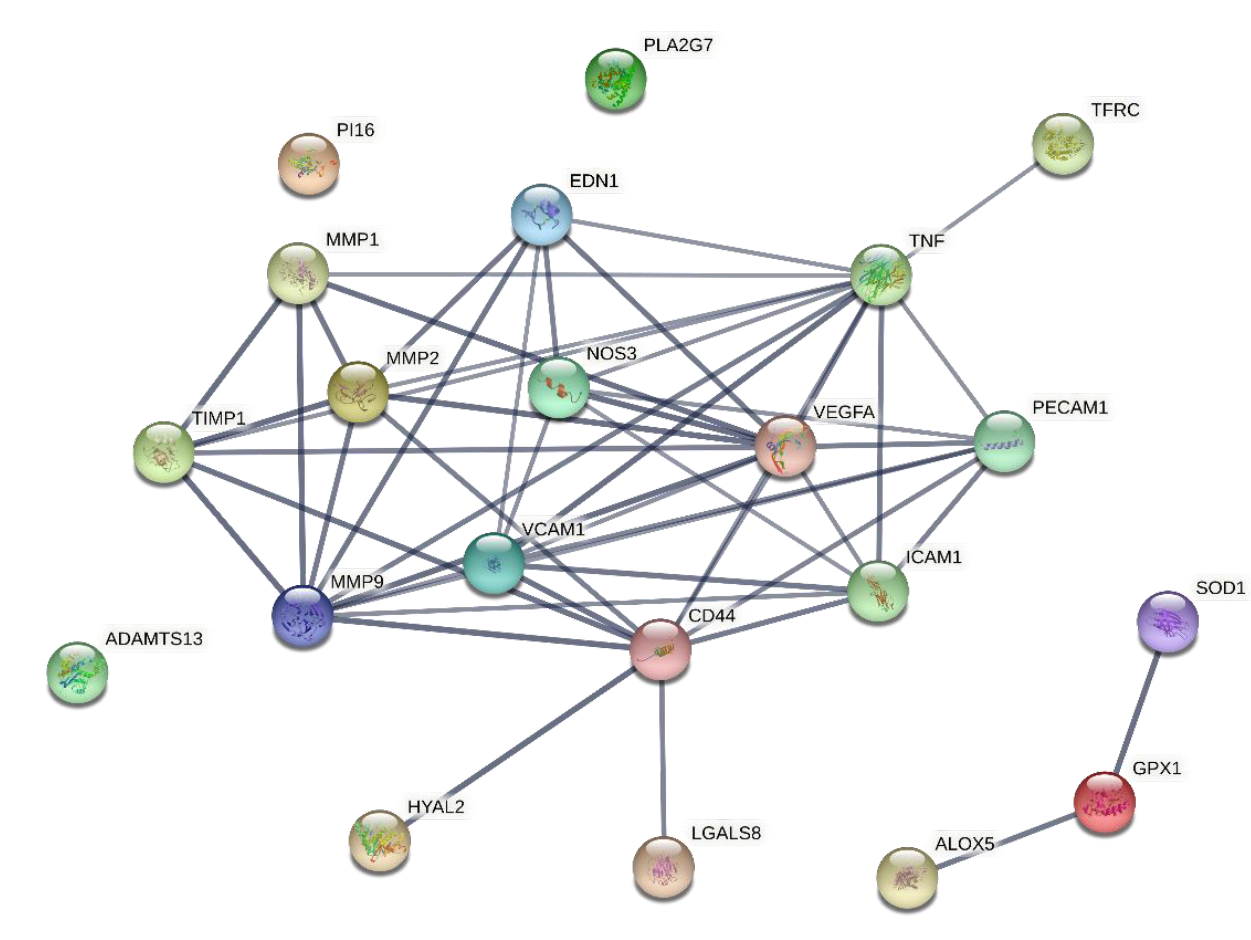
Figure 2. Protein–protein association network visualized by STRING. Each node represents all the proteins produced by a single, protein-coding gene locus, while each edge represents the number of protein–protein associations. Only interactions with a high confidence score of ≥ 0.7 are shown. The color saturation of the edges represents the confidence score of the functional association [17]. ADAMTS13 = ADAM Metallopeptidase with Thrombospondin Type 1 Motif 13; ALOX5 = Arachi- donate 5-Lipoxygenase; CD31 = Platelet And Endothelial Cell Adhesion Molecule 1; CD44 = Hyalu- ronan receptor; EDN1 = Endothelin 1; GPX1 = Glutathione peroxidase 1; HYAL2 = Hyaluronidase 2; ICAM1 = Intercellular Adhesion Molecule 1; LGALS8 = Galectin 8; MMP1 = Matrix metallopro- teinase 1; MMP2 = Matrix metalloproteinase 2; MMP9 = Matrix metalloproteinase 9; NOS3 = Endo- thelial nitric oxide synthase; PI16 = Peptidase Inhibitor 16; PLA2G7 = Phospholipase A2 Group VII; SOD1 = Superoxide dismutase 1; TFRC = Transferrin Receptor; TIMP1 = TIMP Metallopeptidase Inhibitor 1; TNF = Tumor Necrosis Factor; VCAM1 = Vascular cell adhesion molecule 1; VEGFA = Vascular endothelial growth factor A.